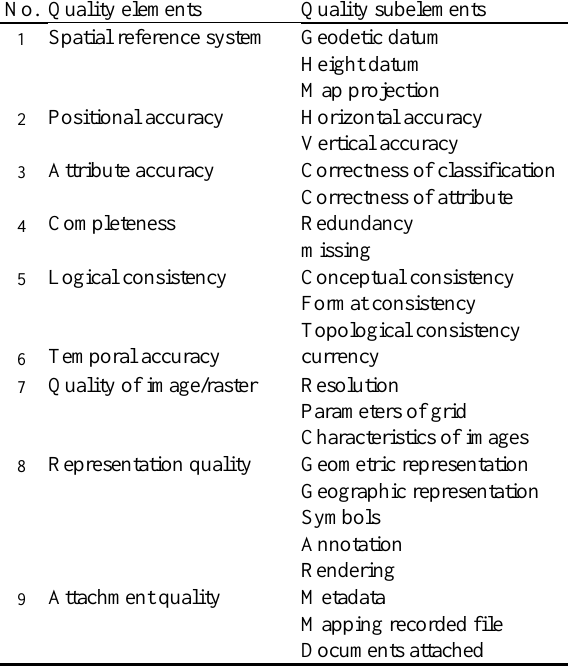
Table 1: quality elements and